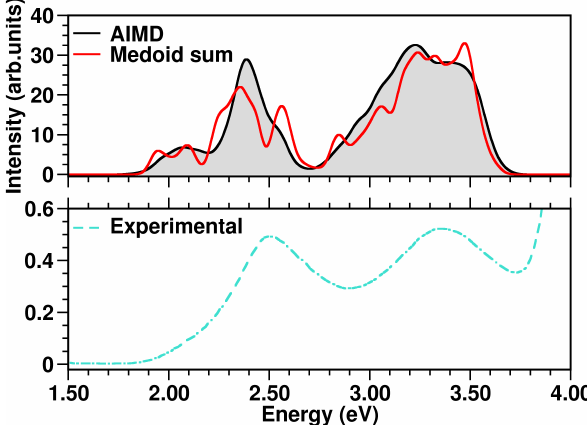
Figure 11. Top panel: comparison of N3 4 − simulated absorption spectra in the 1.50–4.00 eV range. Bottom panel: experimental N3 4 − UV-Vis spectrum, retrieved from Ref. [114], measured in water solution. The color code is presented in the graph legend.